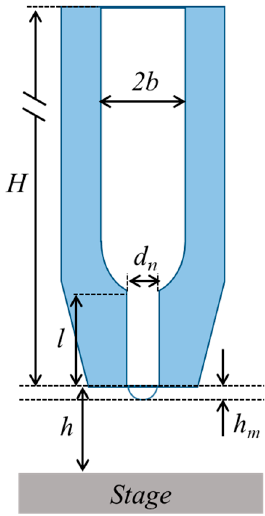
Figure 3. Schematics of nozzle: ρ = density of ink, γ = surface tension of ink, υ = viscosity of ink, H = approximate ink column height from ink reservoir to free end of nozzle, b = radius of capillary far above nozzle, h = distance between nozzle and substrate, h m = meniscus height, d n = inner diameter of nozzle, and l = total length of thinnest part of nozzle.